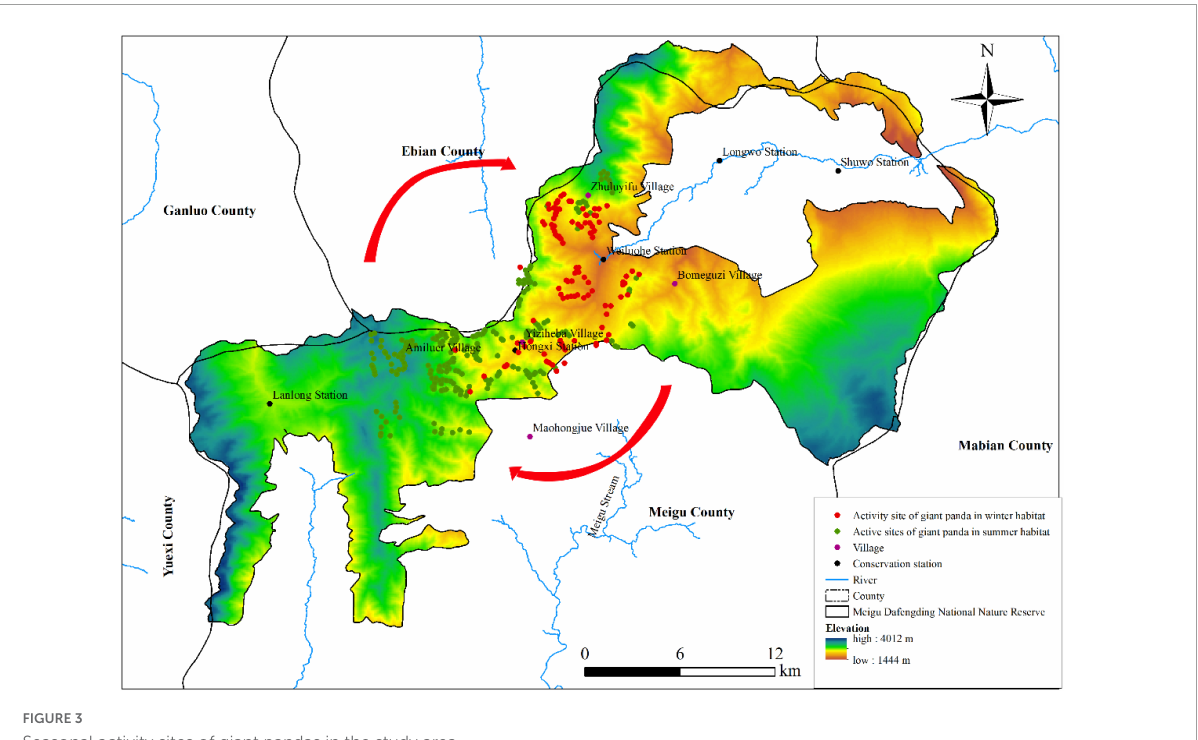
FIGURE3 Seasonal activity sites of giant pandas in the study area.